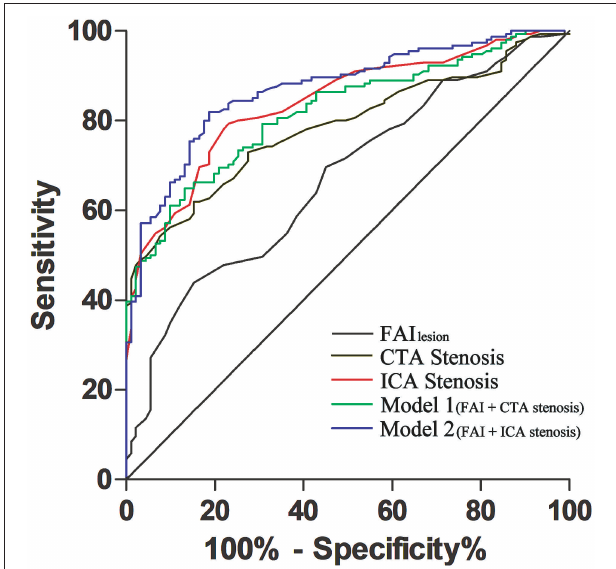
FIGURE 5 | Comparison of the receiver operating characteristic (ROC) curves between different predictors. FAI lesion + computed tomography angiography (CTA) stenosis had a similar AUC as invasive coronary angiography (ICA) stenosis alone (0.820 vs. 0.839, p = 0.39); FAI lesion could also provide incremental diagnostic value to ICA stenosis (0.869 vs. 0.839, p = 0.03). AUC, area under the curve; FAI lesion , lesion-specified fat attenuation index; CTA, computed tomography angiography; ICA, invasive coronary angiography; Model 1, FAI lesion + CTA stenosis; Model 2, FAI lesion + ICA